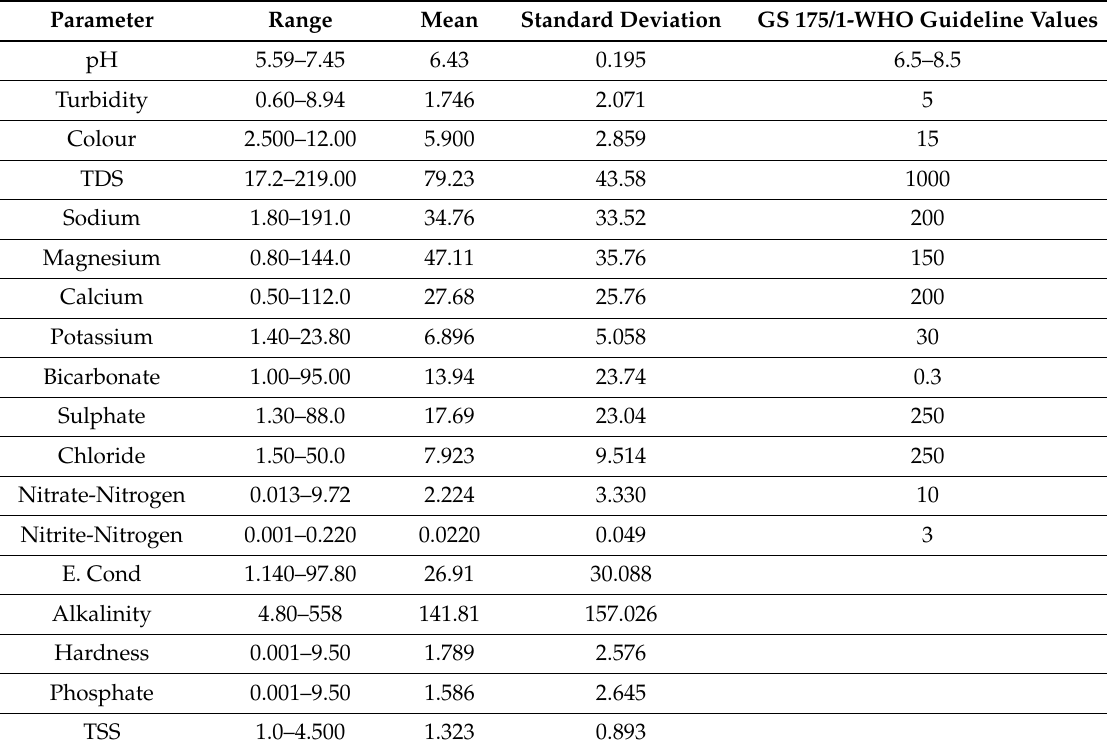
Table 3. Descriptive statistics for physic-chemical parameter for water samples from the study